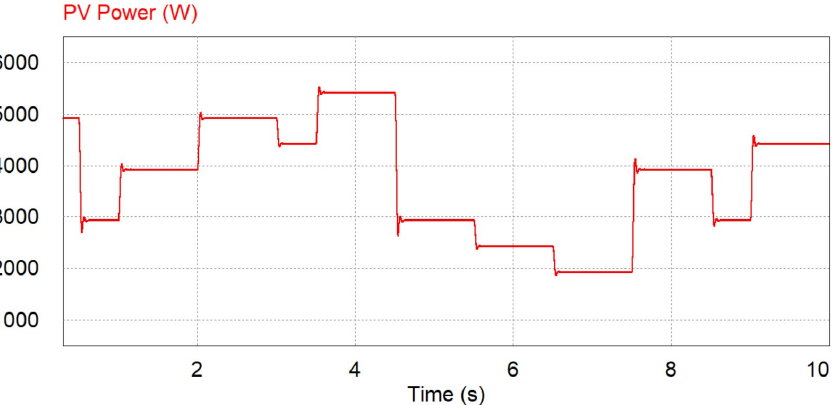
Figure 21. The power of PV.